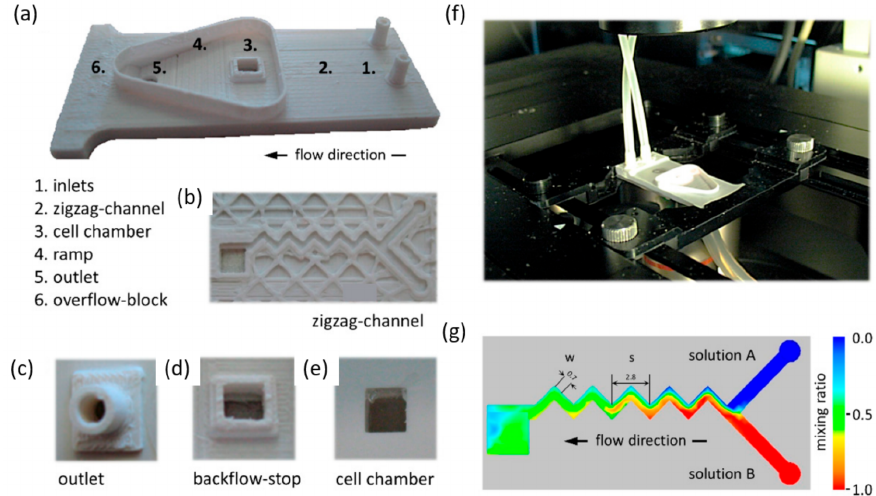
Figure 29. Three-dimensional printed microfluidic platform and simulation of fluid dynamics. ( a ) 3D printed lab-on-a-chip platform with inlets (1), zigzag-shaped microfluidics channel (2), cell chamber (3), ramp (4), overflow block (5), and outlet (6). ( b ) View onto the microfluidic zigzag-shaped channel of an incompletely printed chip. ( c ) Outlet for connection with drainage tubing. ( d ) Top view of the cell chamber, surrounded by a backflow stop to support an outward-directed, unidirectional flow of perfused solution. ( e ) Bottom view of the cell culture chamber through a glass window, mounted with a biocompatible silicone elastomer. ( f ) 3D printed lab-on-a-chip platform with connected tubing for functional imaging using a high-content microscope. ( g ) Dimensions of the zigzag-shaped microchannel for generation of homogeneous mixtures, integrating a “Y” junction, with w, the width of the zigzag channel and s, the linear length of the periodic step. False-color representation of simulated fluid dynamics within the platform for two different solutions, “solution A” (blue) and “solution B” (red). The green color inside the cell chamber indicates a mixing ration of approximately 0.5, and thus demonstrates homogeneous distribution of efficiently mixed solutions. Reprinted from an open-access source